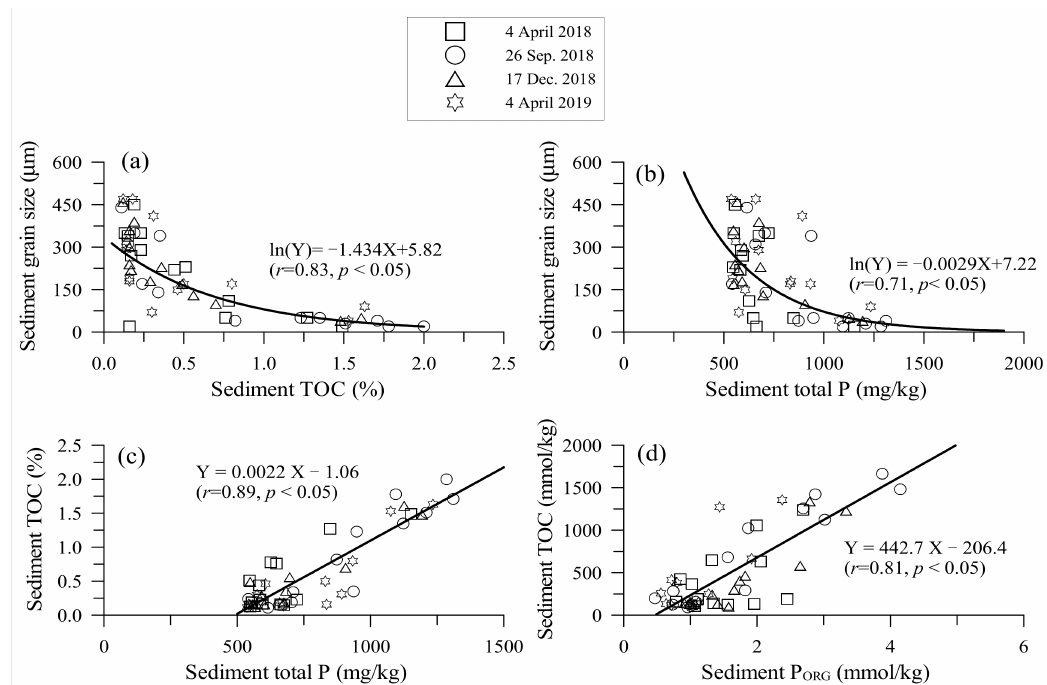
Figure 10. Scatter plots of ( a ) TOC against grain size, ( b ) total P against grain size, ( c ) total P against TOC and ( d ) P ORG against TOC in the DRE surface